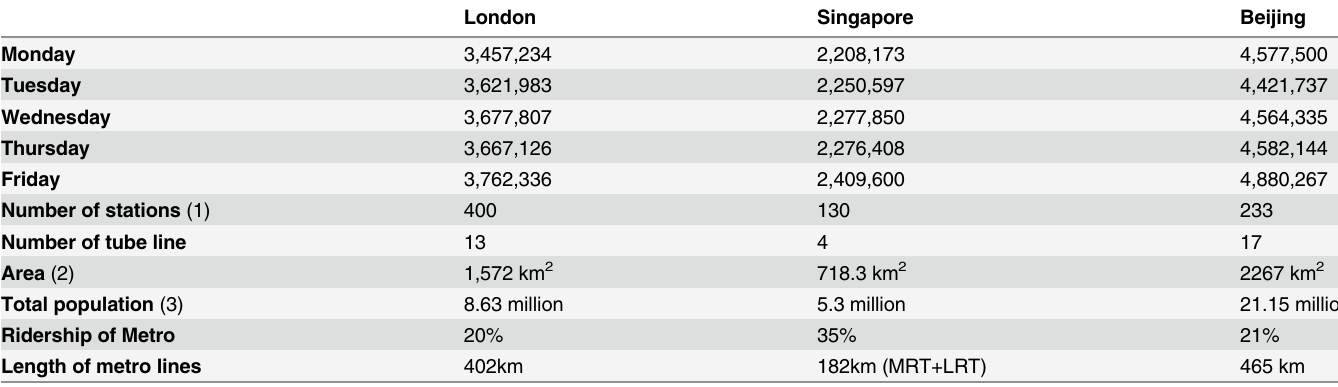
Table 1. Summary statistics of one-week of smart-card data (metro trips